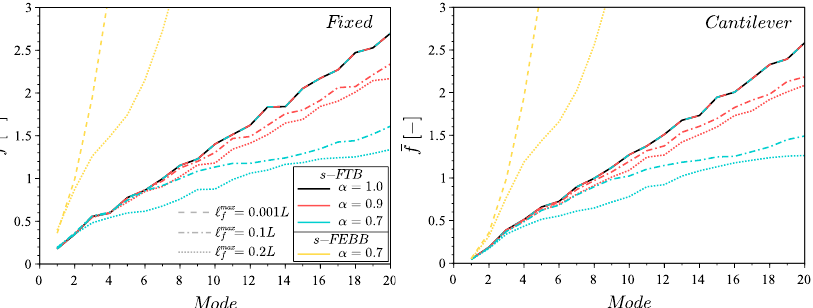
Figure 4. Dimensionless frequency ¯ f for the s-FTB model for the fixed beam and cantilever beam with length to height ratio L / b = 2 and Poisson’s ratio ν = 0.2, for α = [ 0.9, 0.7 ] and (cid:96) max [ 0.001 L , 0.1 L , 0.2 L ] compared to the results of CTB model (s-FTB model with α = 1.0) and the results of s-FEBB model with α = 0.7.